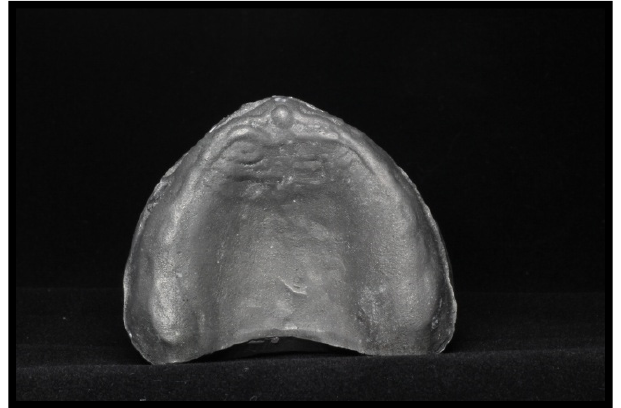
Figure 2. Titanium high-alveolar-ridge master model for sample construction.